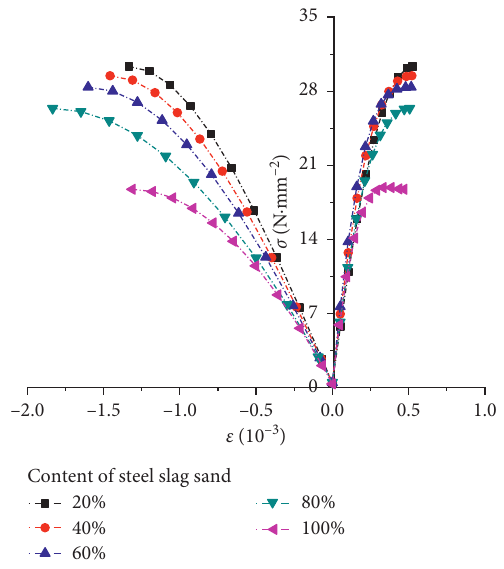
Figure 25: The impact of the content of steel slag sand on the stress-strain curves.